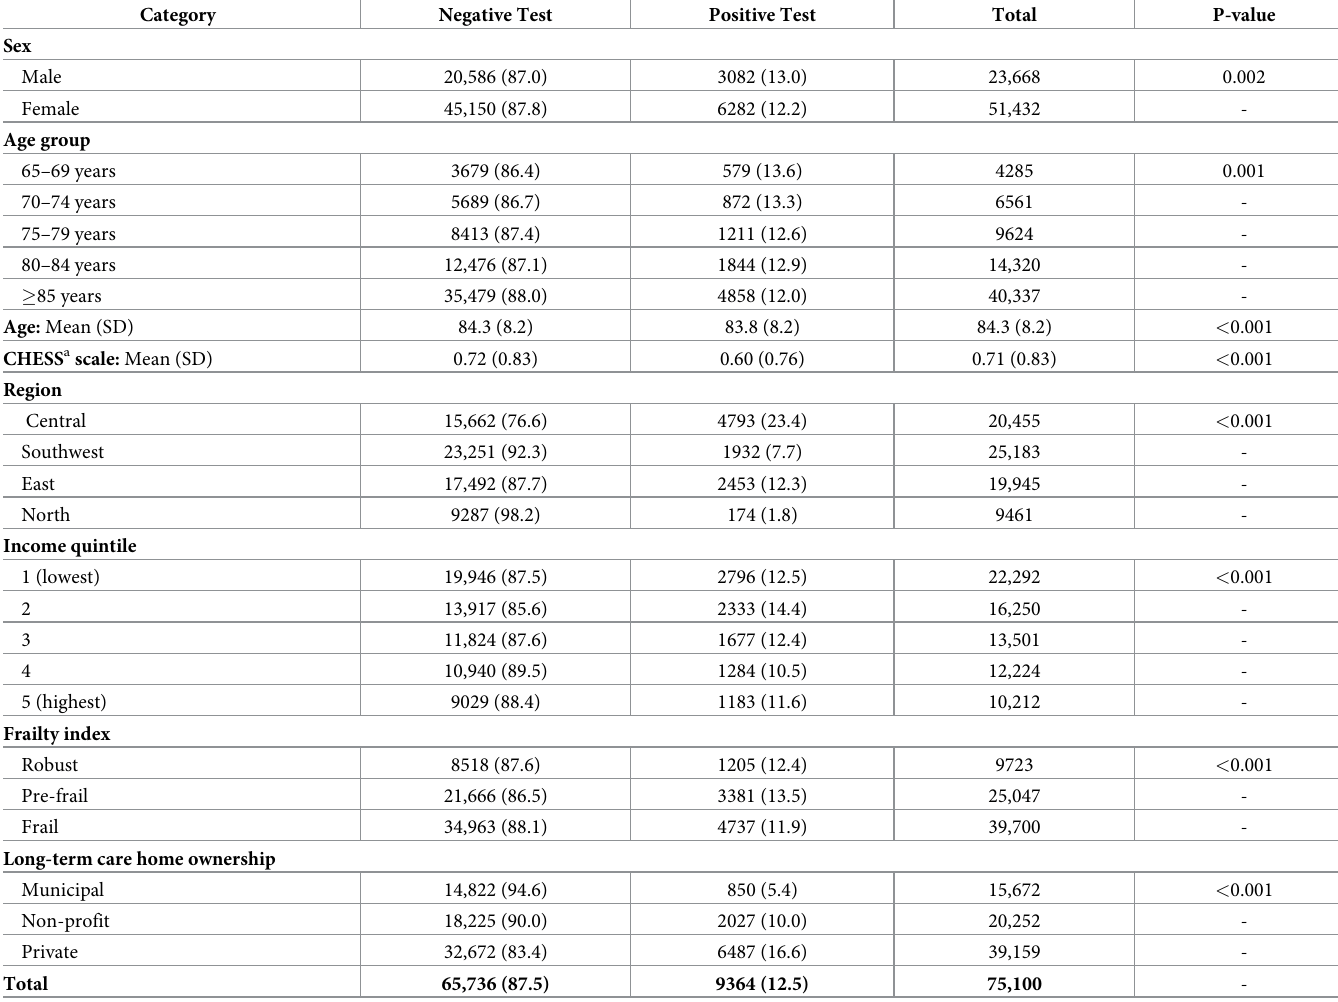
Table 1. Distribution, n (%), of COVID-19 tests based on demographics from March 2020 to December 2020.